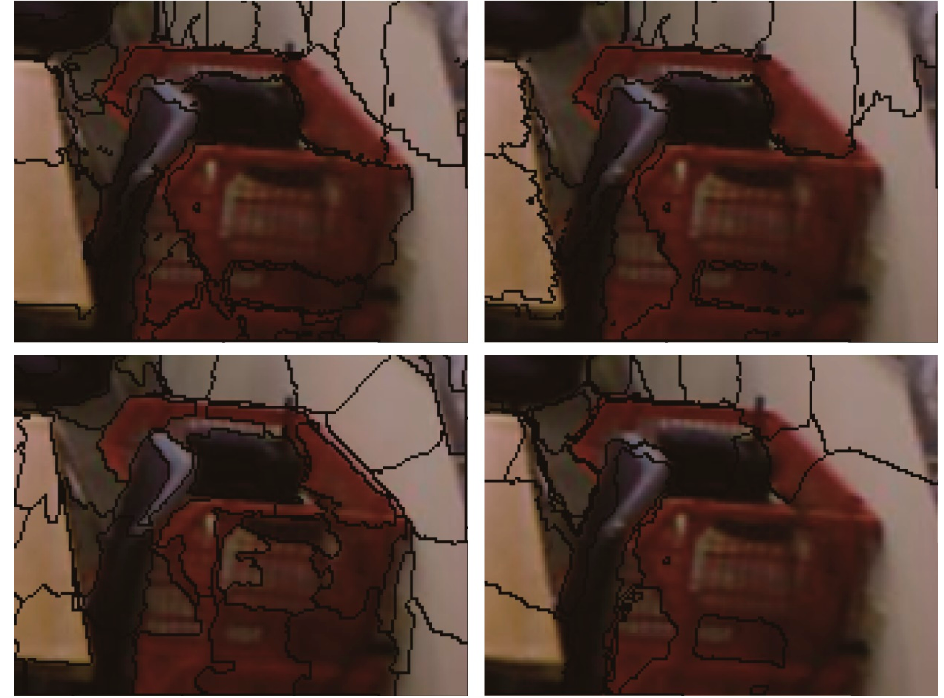
Figure A2. Partially enlarged details of superpixels. From top to bottom are the results of SLIC, DASP, VCCS, and WCFC, respectively. The average superpixel size is approximately 500 pixels in the left column of each image and approximately 300 in the right column.